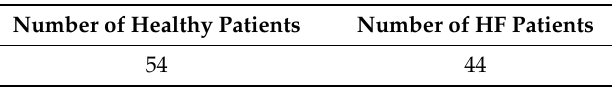
Table 1. Dataset distribution.